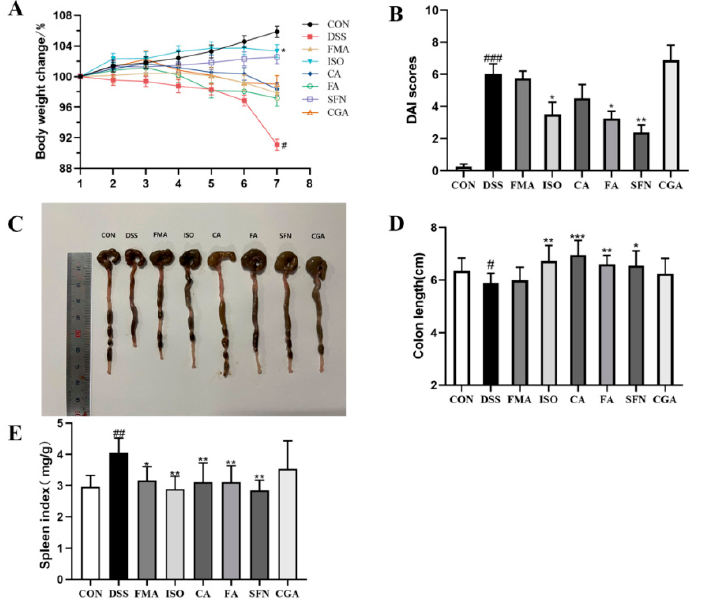
Figure 3. Effects of FECs on weight change, DAI score, colonic shortening and splenic index in DSS-induced mice. ( A ) Body weight changes; ( B ) DAI scores at the end; ( C ) Images of the colon length; ( D ) Colon length; ( E ) Spleen index. Data are expressed as mean ± SD ( n = 8). # p < 0.05, ## p < 0.01, ### p < 0.001, compared with the CON group; * p < 0.05, ** p < 0.01; *** p < 0.001, compared with the DSS group.